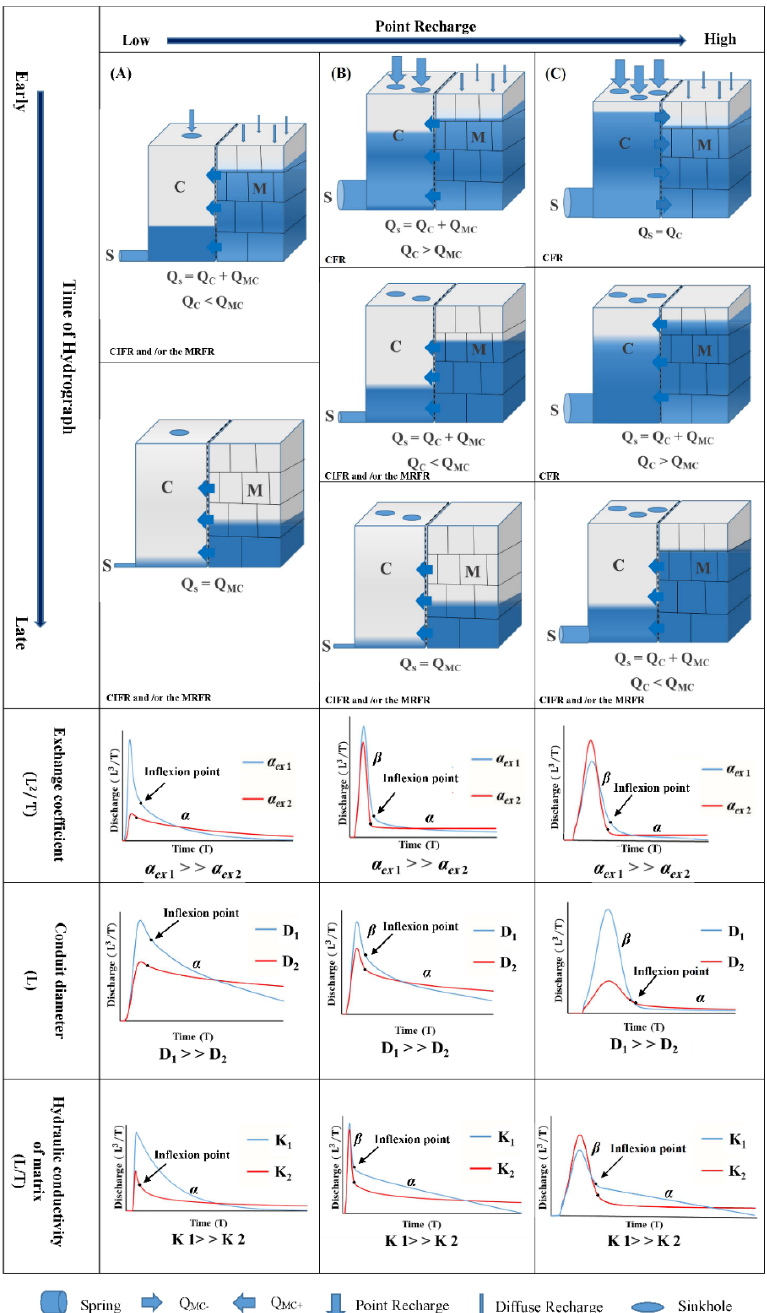
Figure 8. Investigation of the response of the spring hydrograph to the changing of values of exchange coefficient, conduit diameter, and matrix hydraulic conductivity for different scenarios of the history of exchange flow direction and different flow regimes as a result the different values of recharge: column ( A ), CIFR and/or the MRFR with exchange flow Q MC+ as a result of low point recharge. Column ( B ), conduit flow regime in the early time of hydrograph and CIFR and/or the MRFR in the rest of hydrograph time as a result medium point recharge with exchange flow Q MC+ . Column ( C ), conduit flow regime with exchange flow Q MC− and Q MC+ in the early time of the hydrograph and CIFR and/or the MRFR in the rest of time hydrograph as a result of large point recharge. In column A, there is no CFR due to small amounts of point recharge in the karst Also, the inflection point in the recession curve indicates the end of the infiltration aquifer. Under such conditions, the spring hydrograph is influenced by CIFR and/or the and recharge process. In column B, although the CFR can be established in the